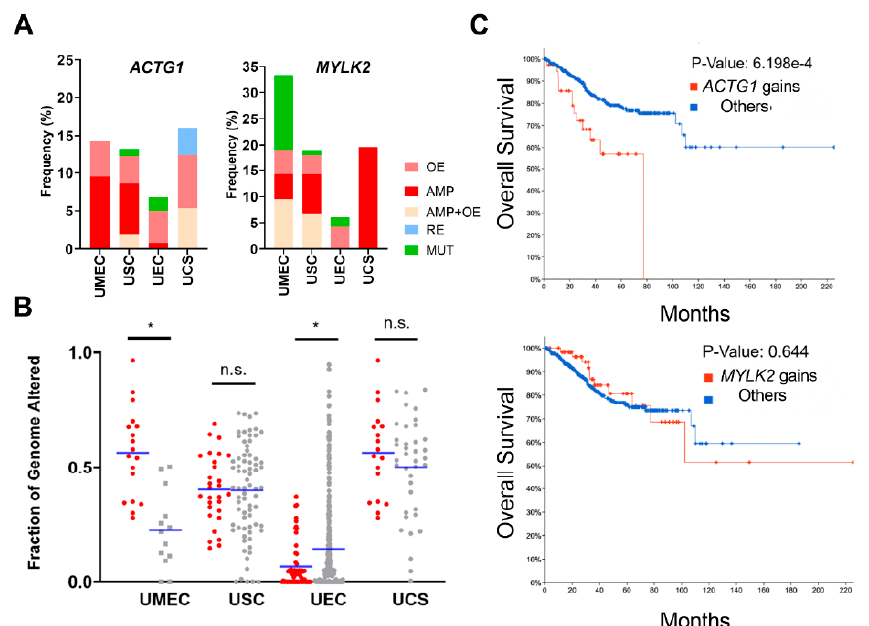
Figure 2. ACTG1 gains are consistently observed across uterine cancer subtypes and predict worse prognosis. ( A ) ACTG1 and MYLK2 genomic alterations in uterine cancers; UMEC = Uterine mixed endometrial carcinoma; USC = Uterine serous carcinoma; UEC = Uterine endometrioid carcinoma; UCS = Uterine carcinosarcoma. OE = overexpression; AMP = amplification; AMP + OE = % amplification + % overexpression; RE = reduced expression; MUT = mutation. Overexpression is indicated by high levels of mRNA while reduced expression is indicated by low levels of mRNA. ( B ) The fraction of the genome (FGA) that is altered in UMEC, USC, UEC and UCS. Red dots indicate ACTG1 and MYLK2 dysregulated tumors, grey dots indicate all other genes in that cancer subtype. ( C ) Kaplan- Meir curves for ACTG1 and MYLK2 in uterine corpus endometrial carcinoma. The altered group represents overall gain, including amplification and overexpression. A p -value of less than 0.05 is considered a statistically significant difference, thus, ACTG1 predicts poor prognosis in uterine cancer.